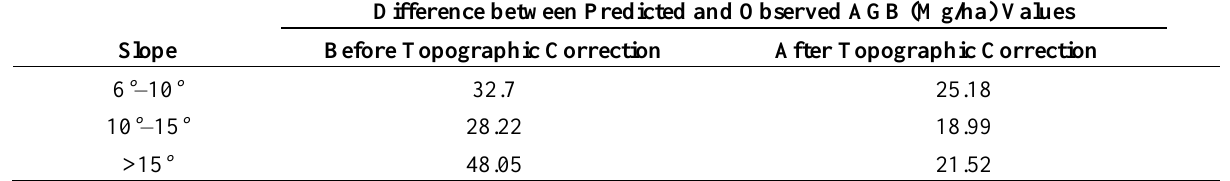
Table 6. Average of difference between predicted and observed AGB (Mg/ha) values before and after topographic correction.